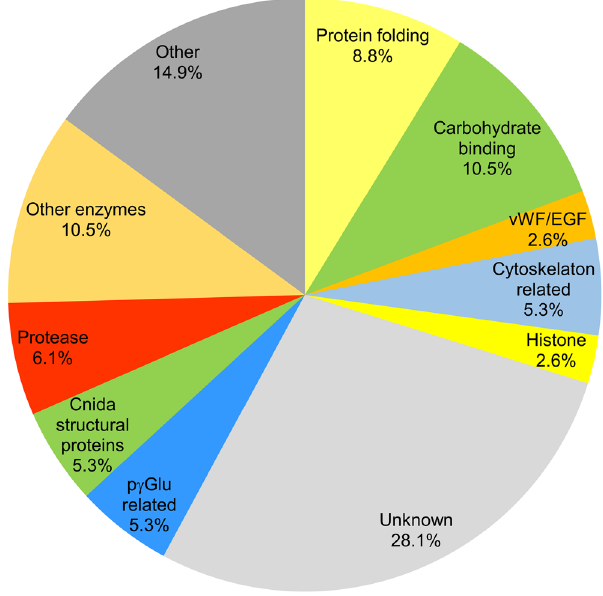
Figure 5. Main protein groups in C. shasta polar capsules identified by proteomic analysis. The polar capsule proteomic profile was divided to functional groups based on annotations and protein domain characterization and the percentage of each group from the 112 identified proteins is shown. For the full list, see Supplementary Table